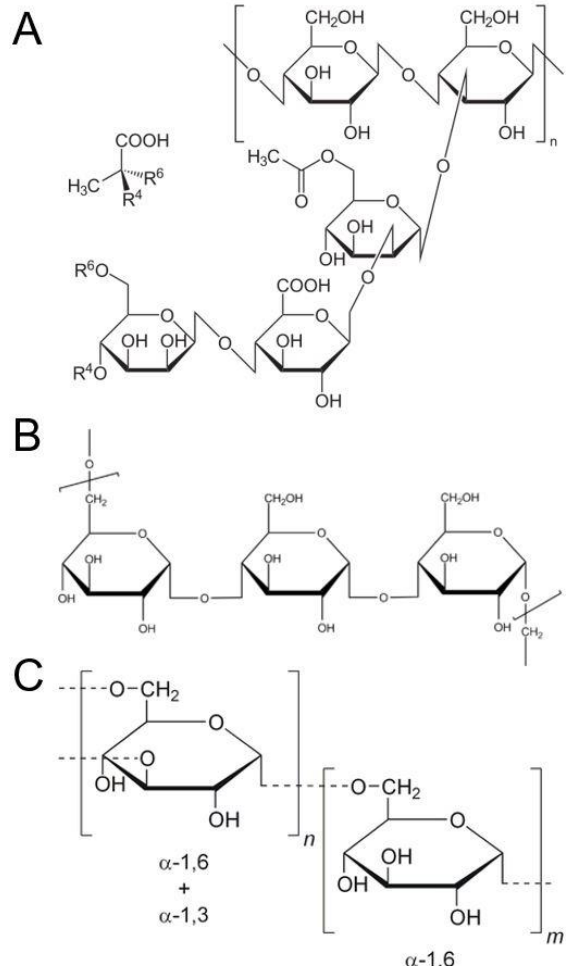
Figure 1. Chemical structures of ( A ) xanthan, ( B ) pullulan, and ( C ) dextran. These structures are in the public domain and are reproduced from a copyright-free repository.